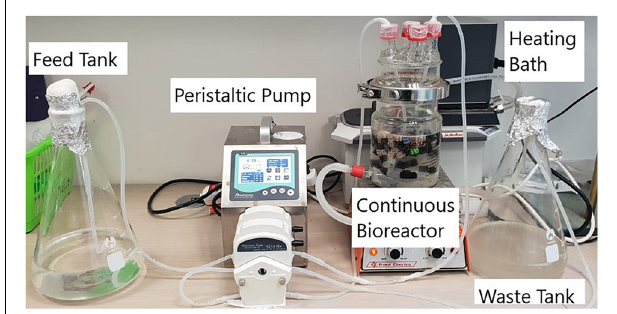
FIGURE 1 | Photograph of the continuous moving bed bioreactor setup including immobilized biomass of Acinetobacter EMY.